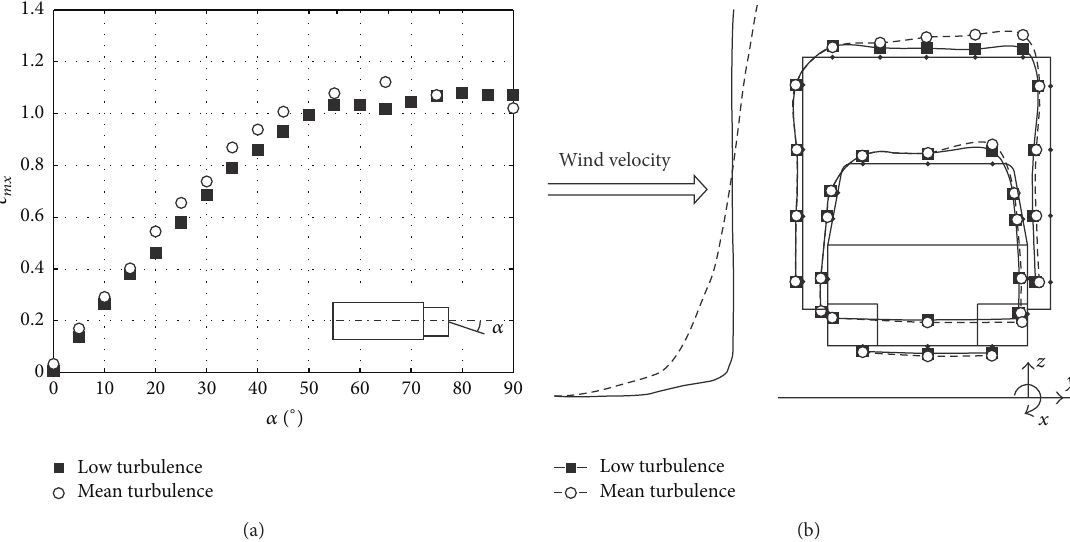
Figure 6: Low turbulence versus mean turbulence effect on the rolling moment coefficient, 𝑐 𝑚𝑥 , on a lorry reported by Cheli et al. [55]. Rolling moment coefficient measured as a function of the yawing angle, 𝛼 (a); and pressure coefficients measured on the surface of the lorry (van and truck) at 𝛼 = 90 ∘ (b). Low and mean turbulence wind profiles are also indicated in the sketch on the right side.